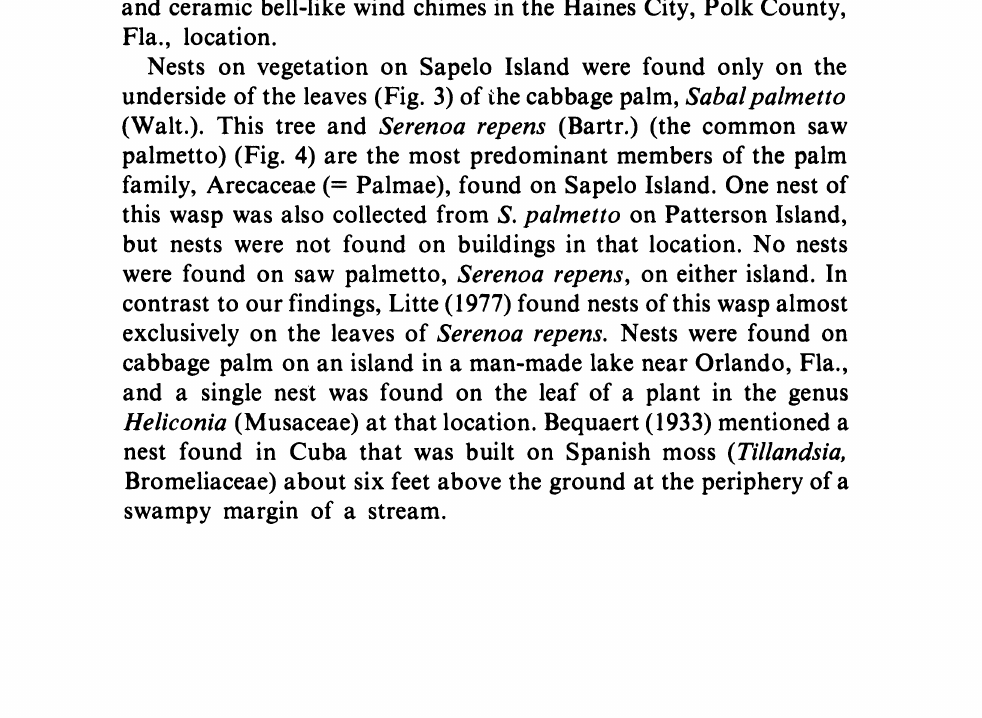
Figures and 2. Nests of M. m. cubicola at Sapelo Island, showing the general structure and safety area on the back of the nest (arrow). concrete arbors. Small (5-15 cells) uninhabited nests (Figs. 1.and 2) were numerous on the wooden frames of windows of the R.